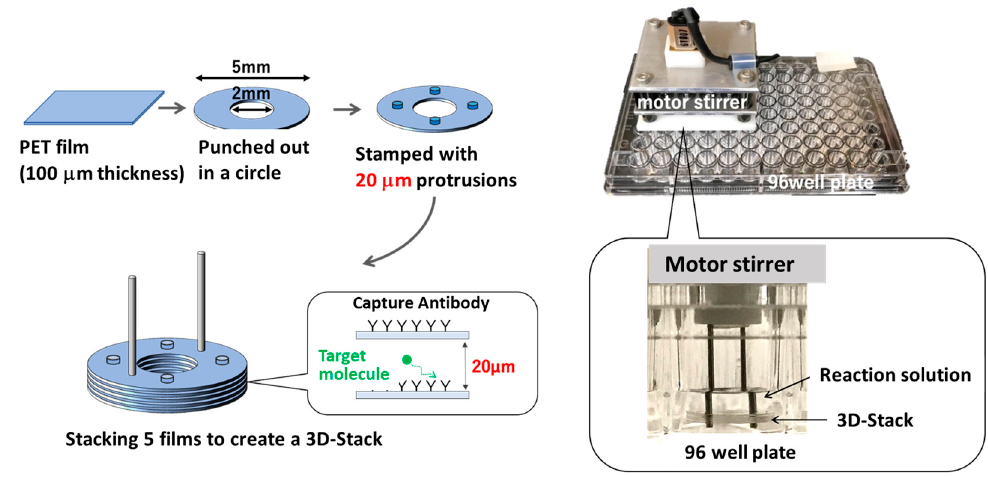
Figure 1. Schematic image for fabrication of 3D-Stack and utilization within a well.